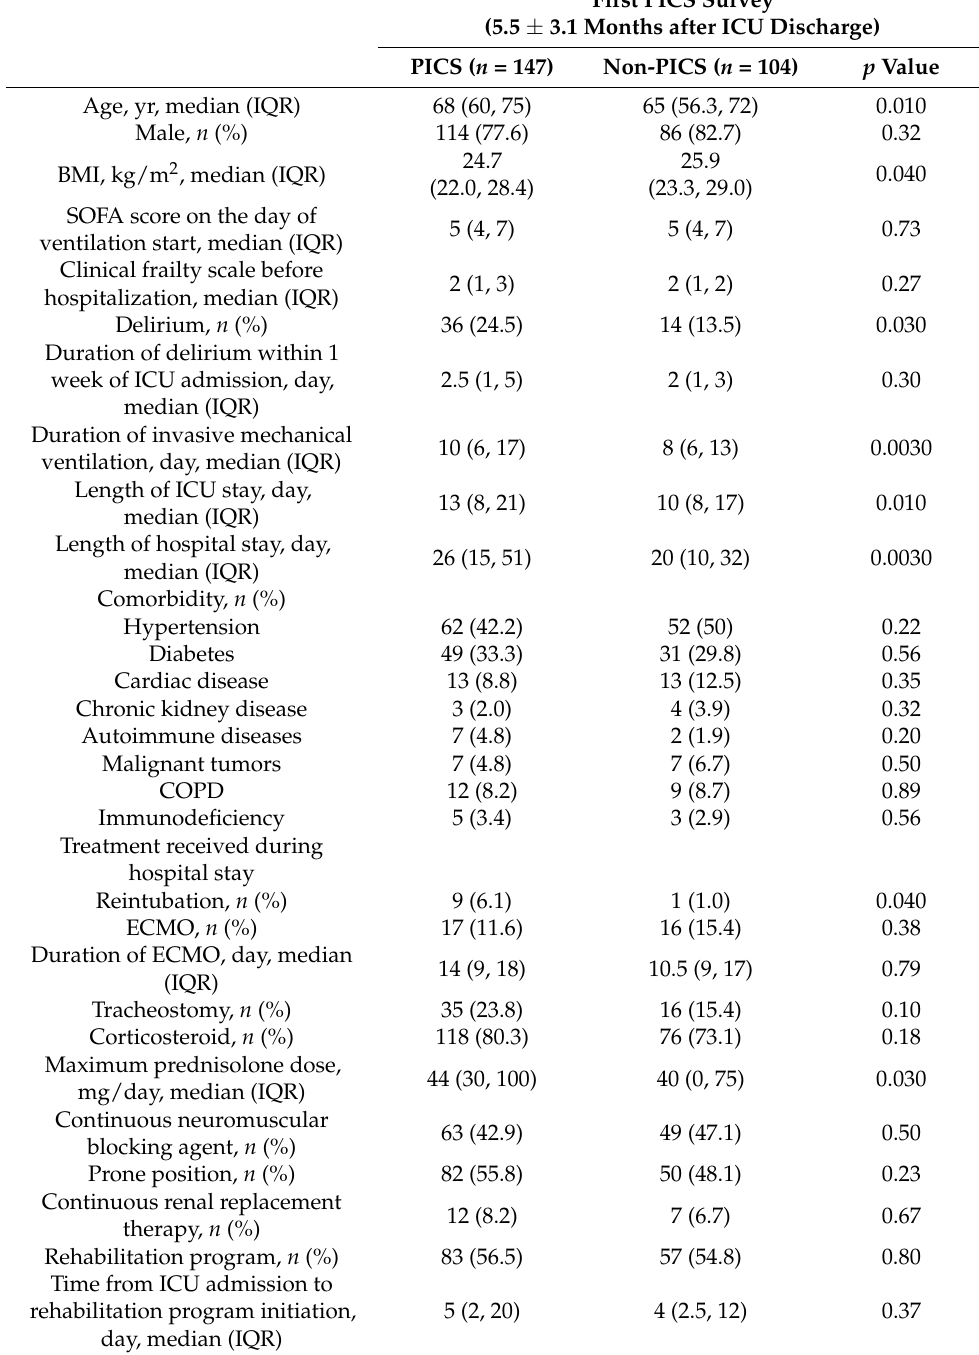
Table 1. Patient characteristics and clinical course in first PICS